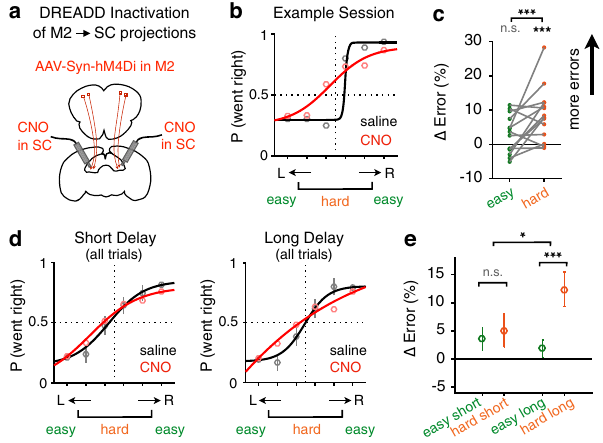
Fig. 5 Inactivation of M2 terminals in SC impairs decision maintenance. a Design for bilateral chemogenetic inactivation of M2 terminals in SC. b Example SC infusion session (red) compared to saline control session (black) for one animal. Dots, data; lines, sigmoid fi t. c Difference in error rate between inactivation sessions ( n = 14) and saline control sessions ( n = 14) for easy (green) and hard (orange) trials. Gray lines connect data from the same session. *** P = 4 × 10 − 4 for hard trials; *** P = 0.001 for easy versus hard trials; n.s. P = 0.06, two-sided permutation test. d , e Psychometric curves ( d ) and error rate increase ( e ) due to M2 terminal inhibition in SC, plotted separately for short delay (0.3 – 0.9 s, n = 2615 CNO trials, and 3090 saline control trials) and long-delay trials (0.9 – 1.5 s, n = 2357 CNO trials, and 2704 saline control trials). d Mean and s.e.m.